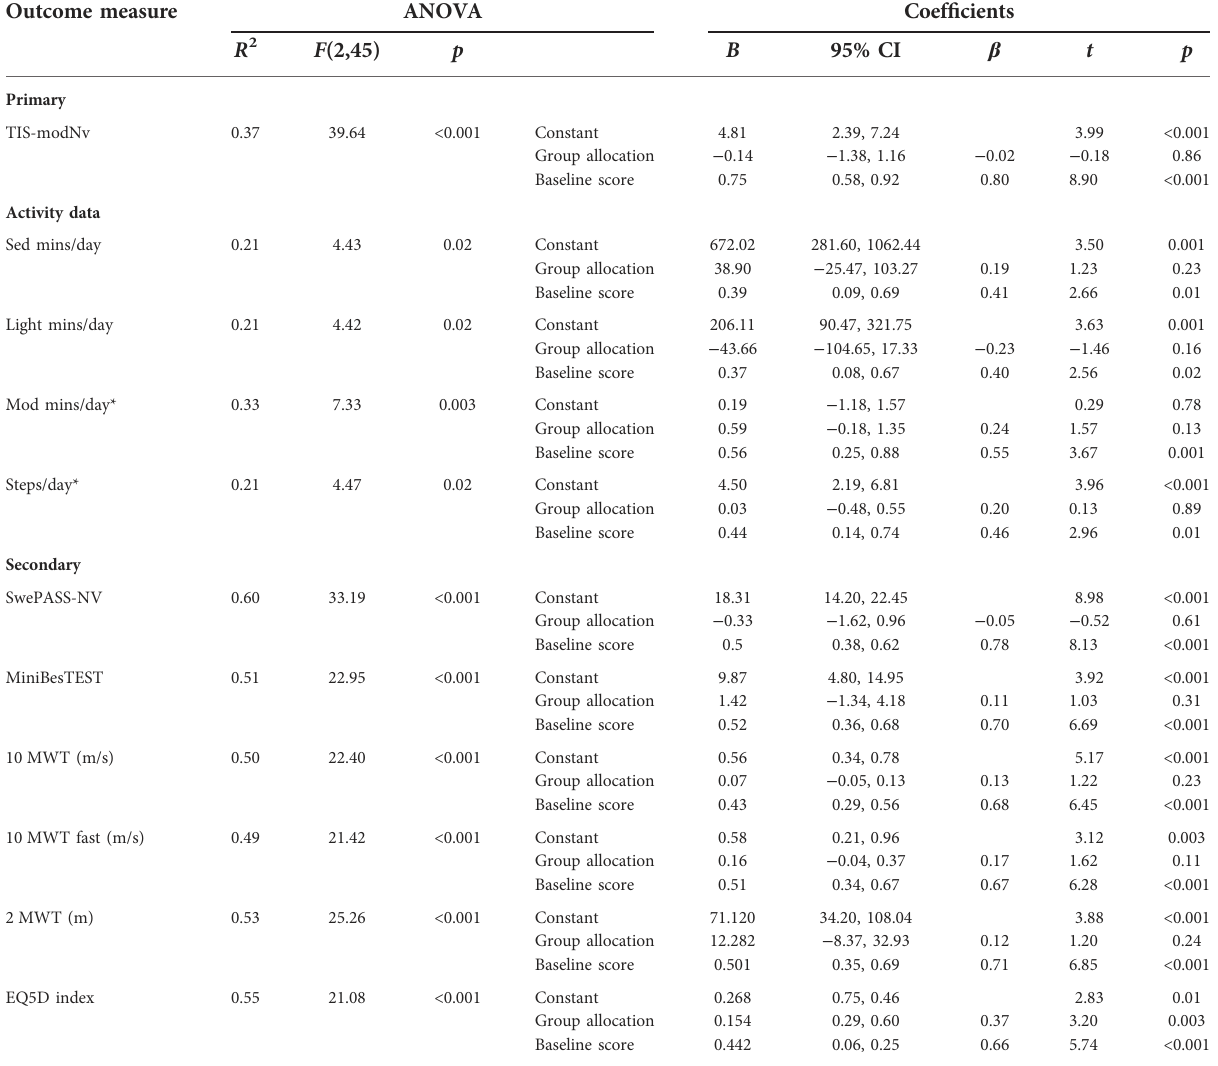
TABLE 3 Regression model. Outcome